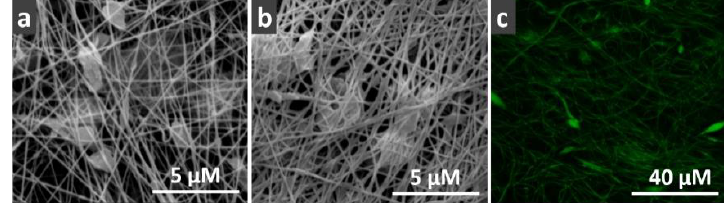
Figure 2. SEM images of ( a ) PAN/O-MMT, and ( b ) PAN/O-MMT/TiO 2 nanofibers. ( c ) Confocal laser scanning microscope (CLSM) micrograph of Lac-immobilized PAN/O-MMT/TiO 2 nanofibers.